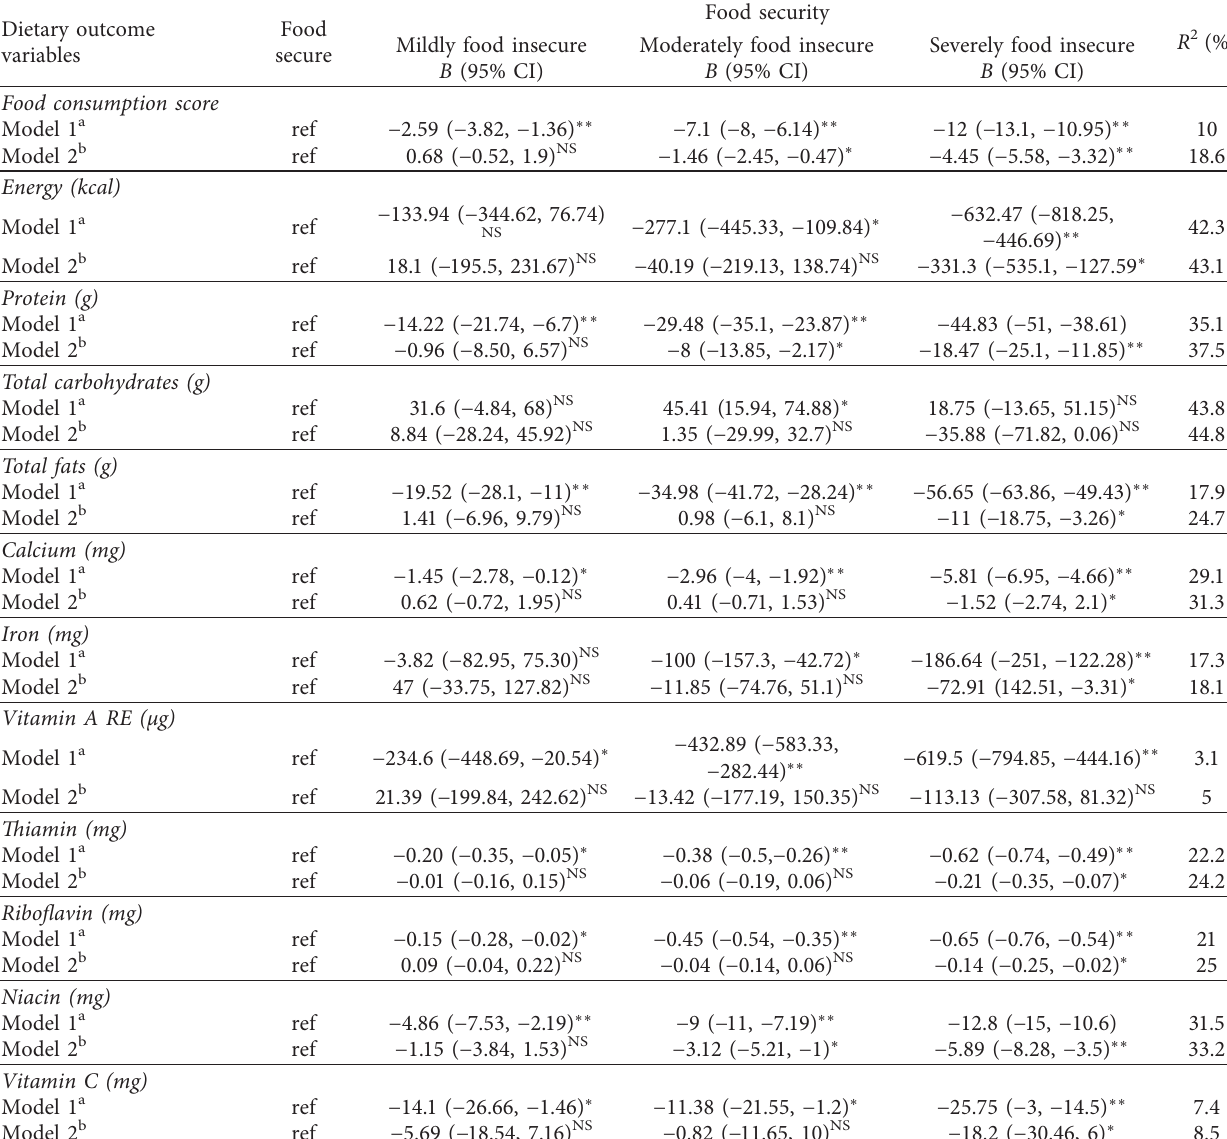
Table 10: Relationship between dietary consumption and food insecurity level ( n � 9668). Dietary